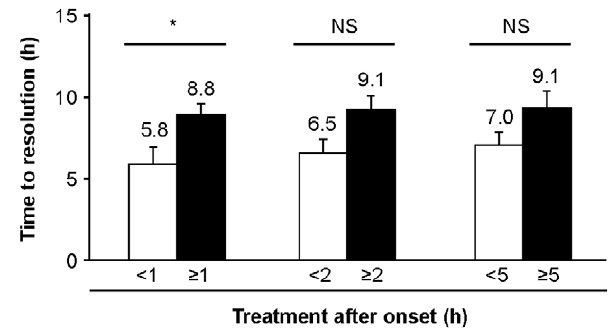
Figure 4. Self-administration of icatibant resulted in earlier treatment. Figure shows proportion of patients treated before and after each timepoint n=72 for HCP-administered patients, n=158 for self-administered patients. All patients are included at each timepoint; *** p = 0.001 for self-administration versus HCP-administra- tion,* p =0.016 for self-administration versus HCP-administration, NS, not significant; HCP, healthcare professional; SA, self-administration.